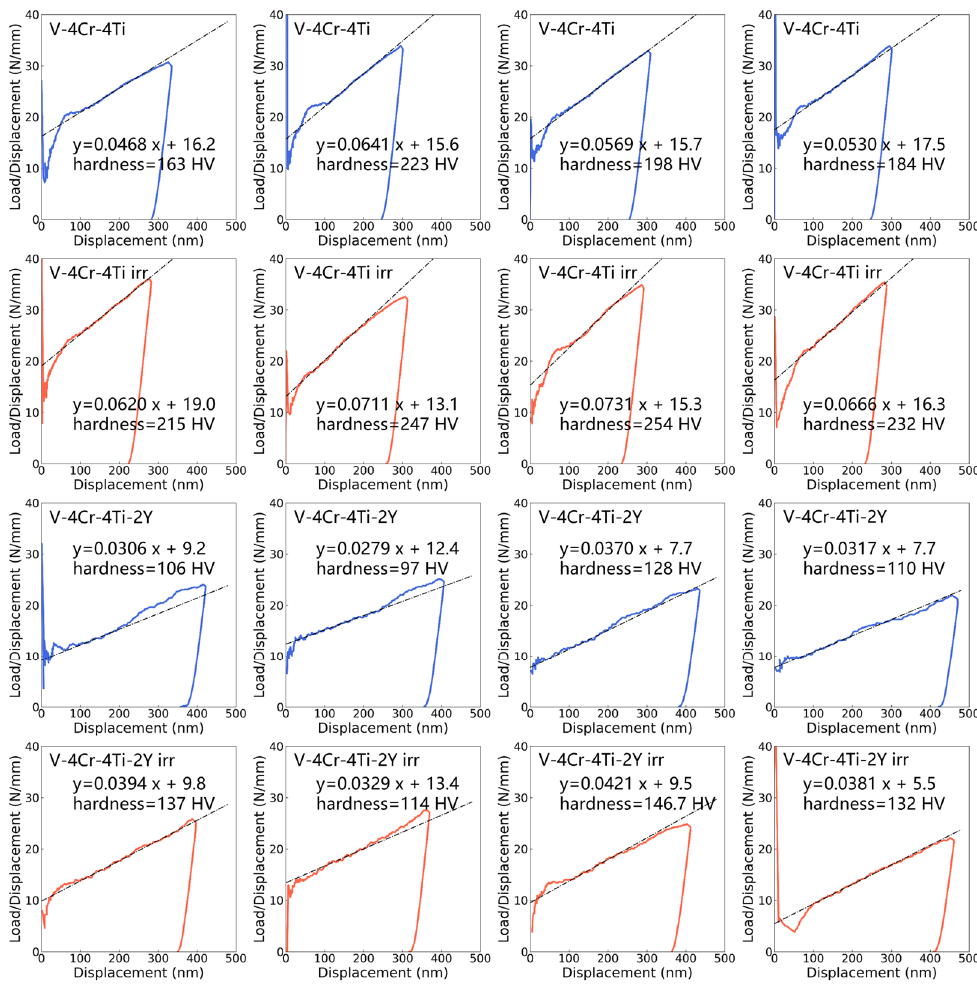
Figure 6. Typical L/d-d plots of all samples and fitting results using the least squares method are marked with black dotted line.